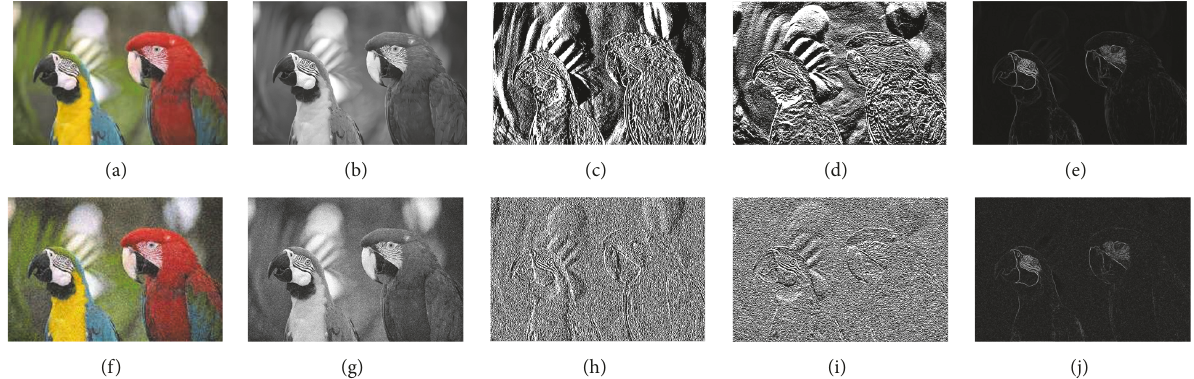
Figure 4: (a) An original reference image, (b) gray image, (c) horizontal image with Prewitt operator, (d) vertical image with Prewitt operator, and (e) edge map of image. ((f)–(j)) A WN distorted version of the image and its corresponding